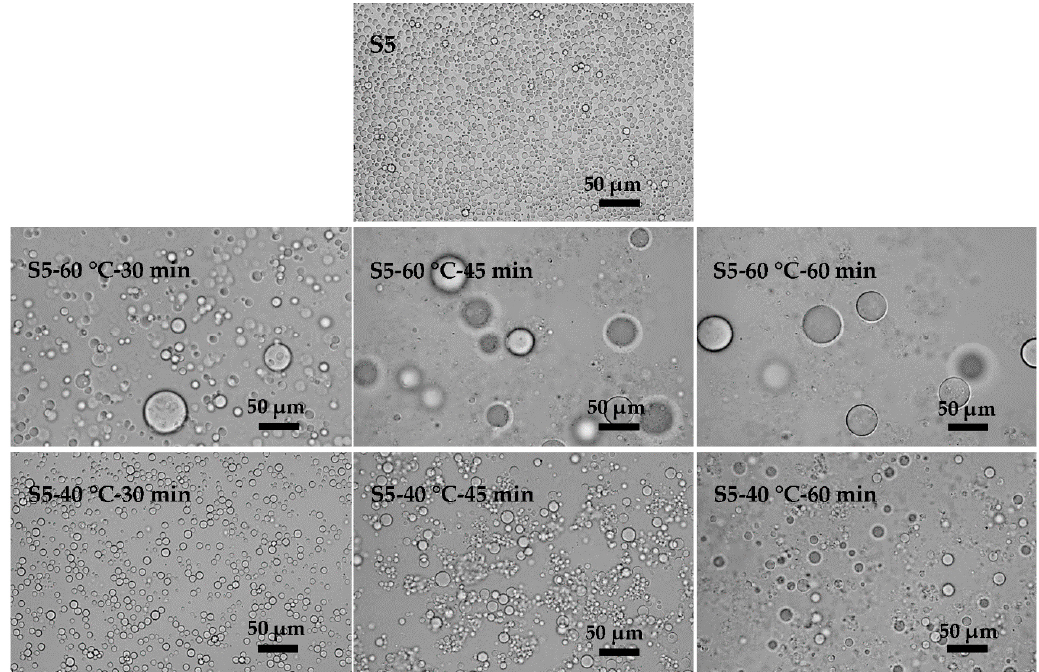
Figure 10. Microscopic photographs of KGM emulsions for S5 . After emulsification, emulsions of S5 were kept at 60 °C (or 40 °C) for 30, 45 and 60 min with stirring.